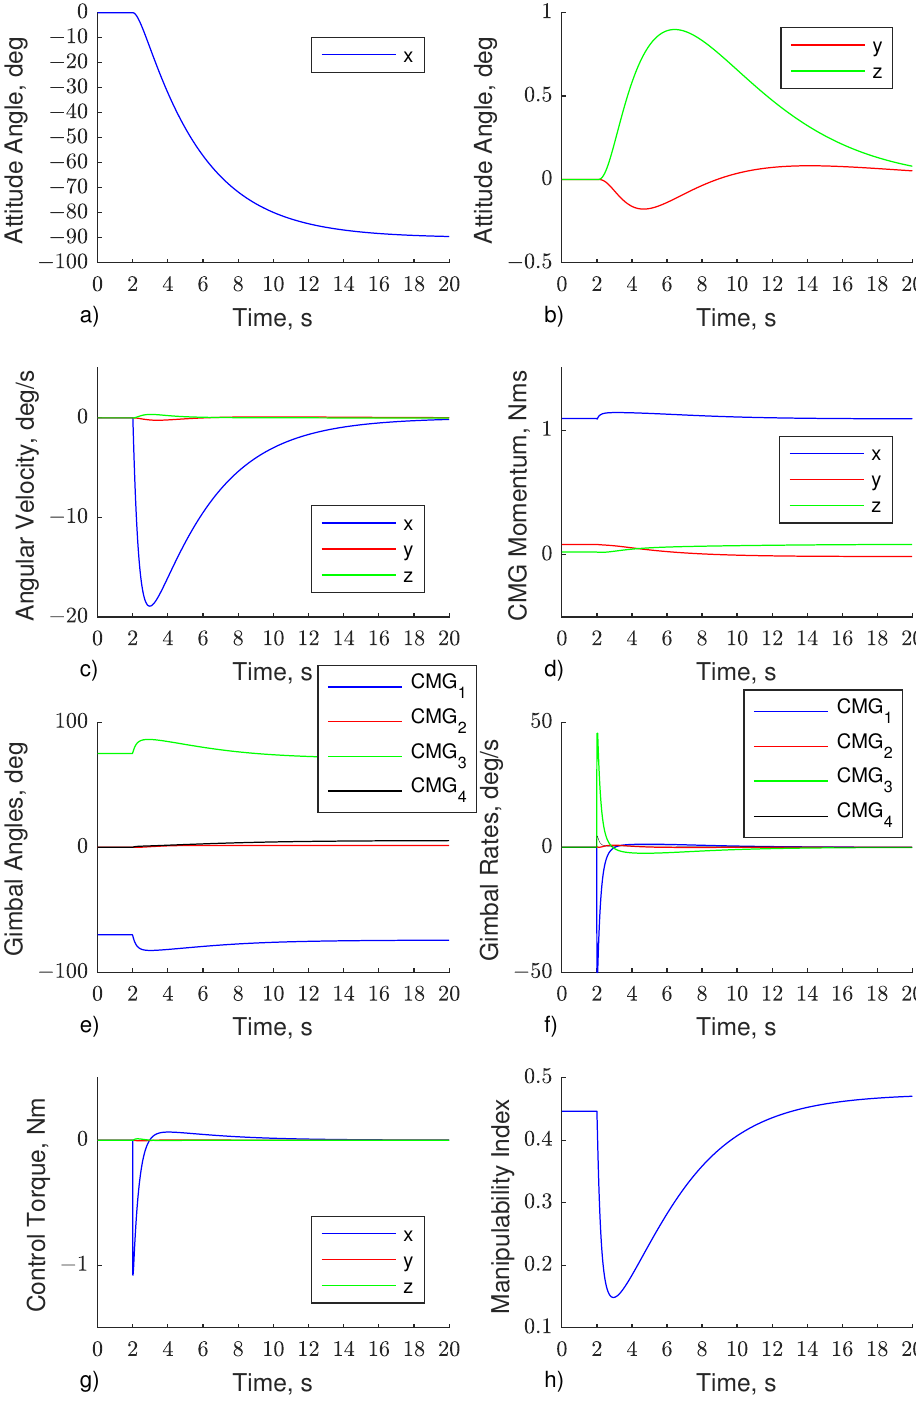
Figure 5. Results derived using the variable speed control moment gyroscope (VSCMG) model. ( a ) Attitude angle in x , ( b ) Attitude angle in y , z , ( c ) Angular velocity, ( d ) CMG momentum, ( e ) Gimbal angles, ( f ) Gimbal rates, ( g ) Control torque, ( h ) Manipulability